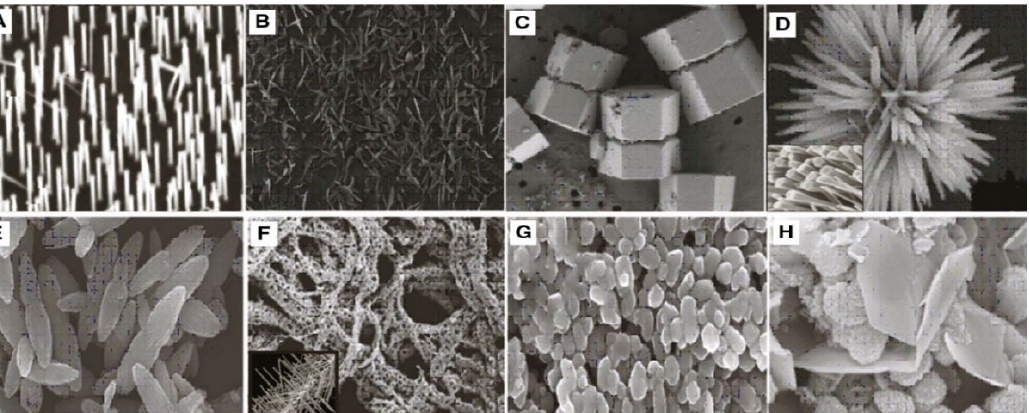
Figure 8. Morphology of ZnO nanostructures: ( A ) needles, rods, and wires; ( B ) helixes and springs; ( C ) nanopellets/nanocapsules; ( D ) flower, snowflake, and dandelion; ( E ) peanut ‐ like; ( F ) interwoven particle hierarchy; ( G ) raspberry, nanosheet/nanoplate; ( H ) circular/round or sphere ‐ shaped. (Reprinted from [209]; open access under CC BY).